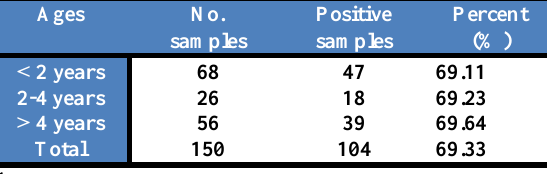
Table, 4: Percentage of positive LSD samples according to cattle ages by